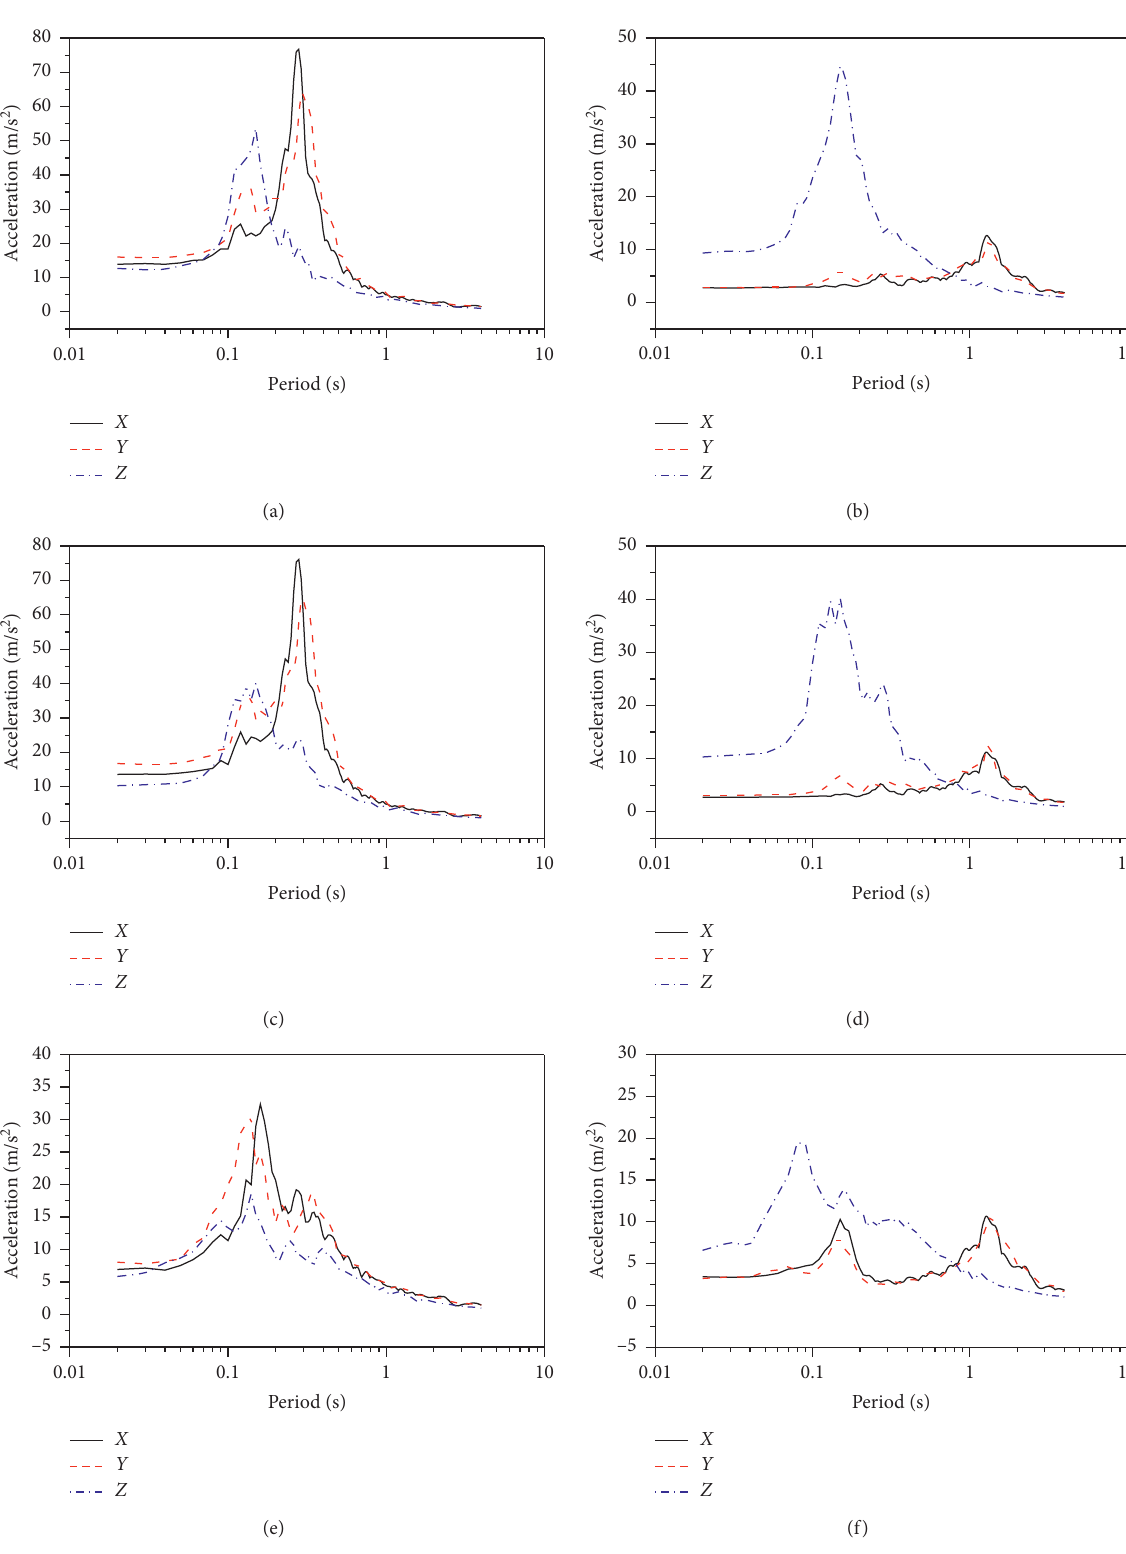
Figure 10: Floor response spectra of two models under artificial ground motion: (a) P1 in model 1, (b) P1 in model 2, (c) P7 in model 1, (d) P7 in model 2, (e) P10 in model 1, and (f) P10 in model